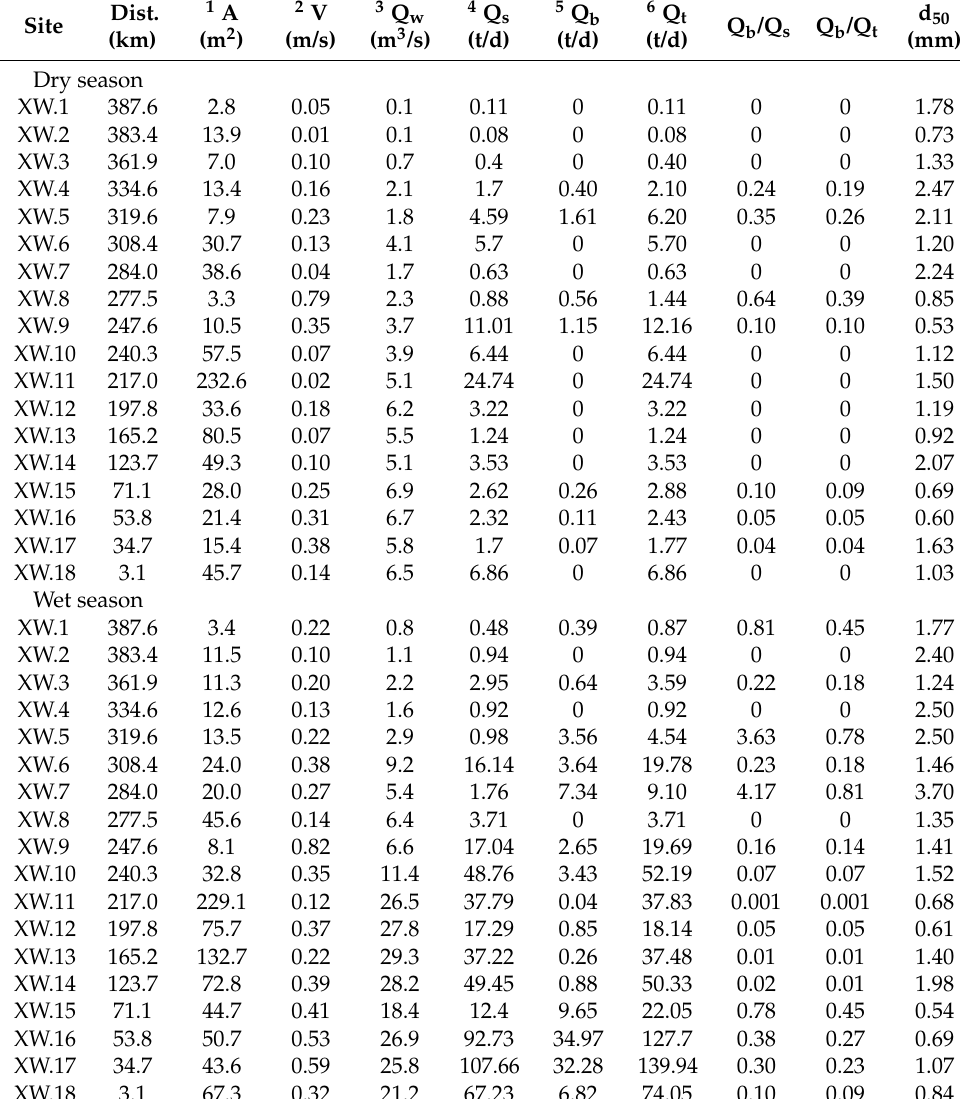
Table 2. Observed streamflow and sediment data along the Wang River